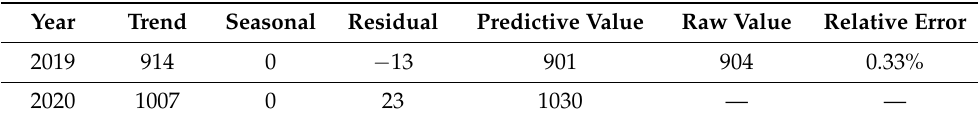
Table 6. Monthly forecast and additional results of housing municipal engineering production safety accidents deaths after trend decomposition. Year Trend Seasonal